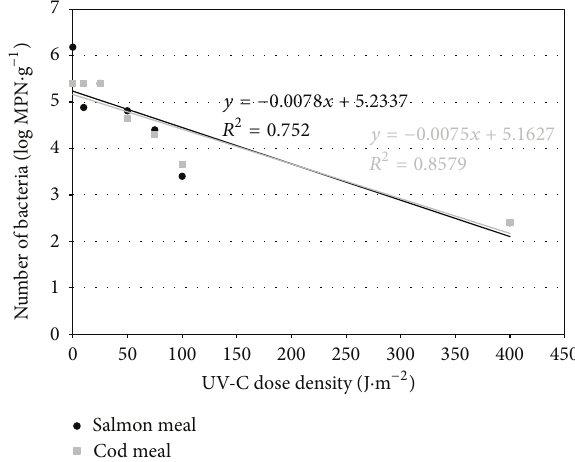
Figure 1: Regression lines describing inactivation kinetics of Salmonella